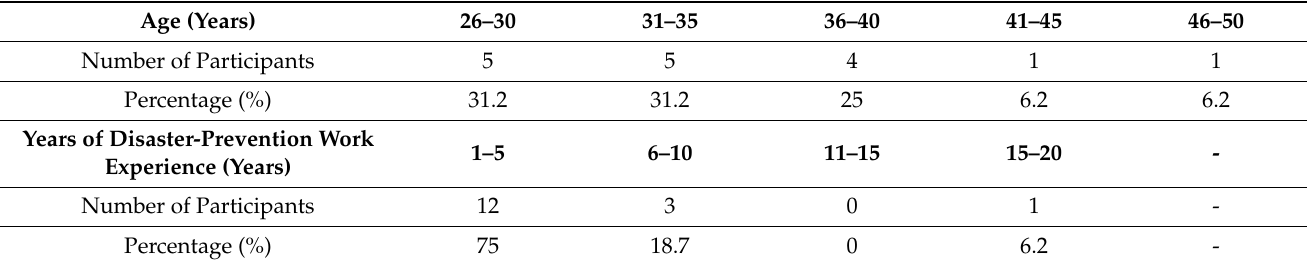
Table 4. The age and years of disaster-prevention work experience distribution of respondents who completed questionnaires. Age